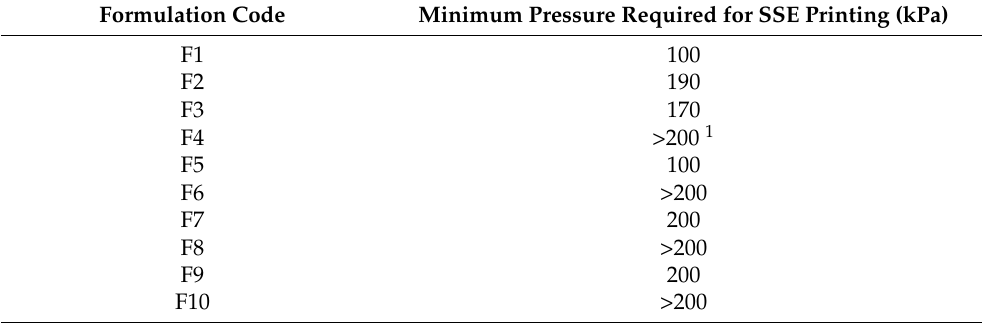
Table 6. Minimum pressure required for SSE printing of each DoE